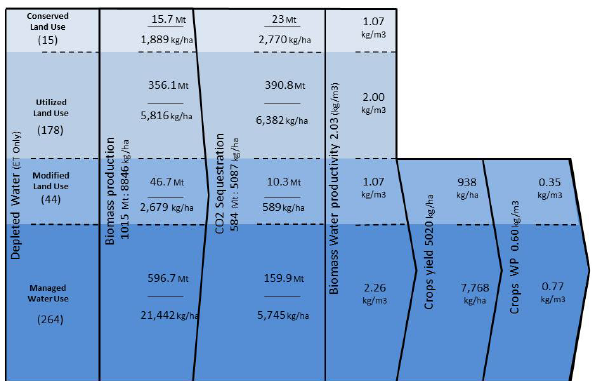
Figure 5. WA+ productivity sheet for the Indus basin pertaining to the year 2007. Water use 3 Fig. 5. WA + productivity sheet for the Indus basin pertaining to the figures are in km 3 4 year 2007. Water use figures are in km 3 .